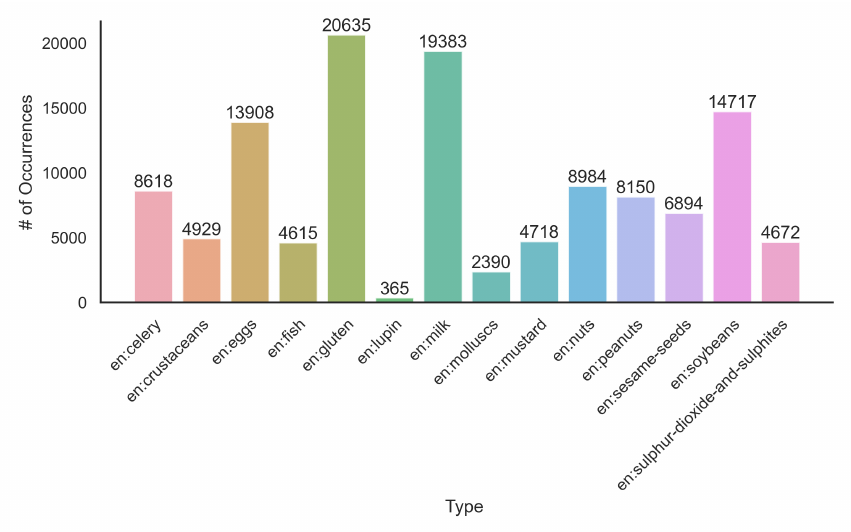
Figure 5. Class distribution of allergens in the cleaned dataset after up-sampling is